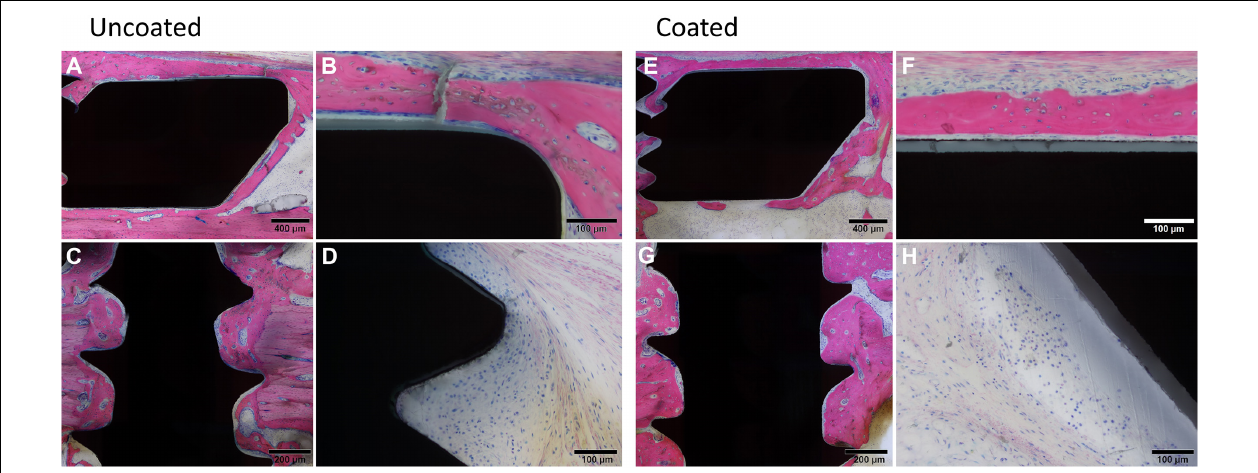
FIGURE 5 | Histological images of rabbits receiving Left, uncoated, or Right, coated LCPs and screws. At euthanasia, 8 weeks after surgery, rabbits were submitted for histopathological processing and evaluation. Giemsa Eosin-stained sections of the plate (A,E) and screws (C,G) are shown that are indicative of typical findings. (B,F) show higher magnification images of (A,E) , respectively. Note the greater bone-implant contact for the screws relative to the plates and a lack of significant differences between the groups. Low to moderate grade infiltration with inflammatory cells was also observed (uncoated, D and coated H ) again without marked differences between the groups. Images were selected as representative of features